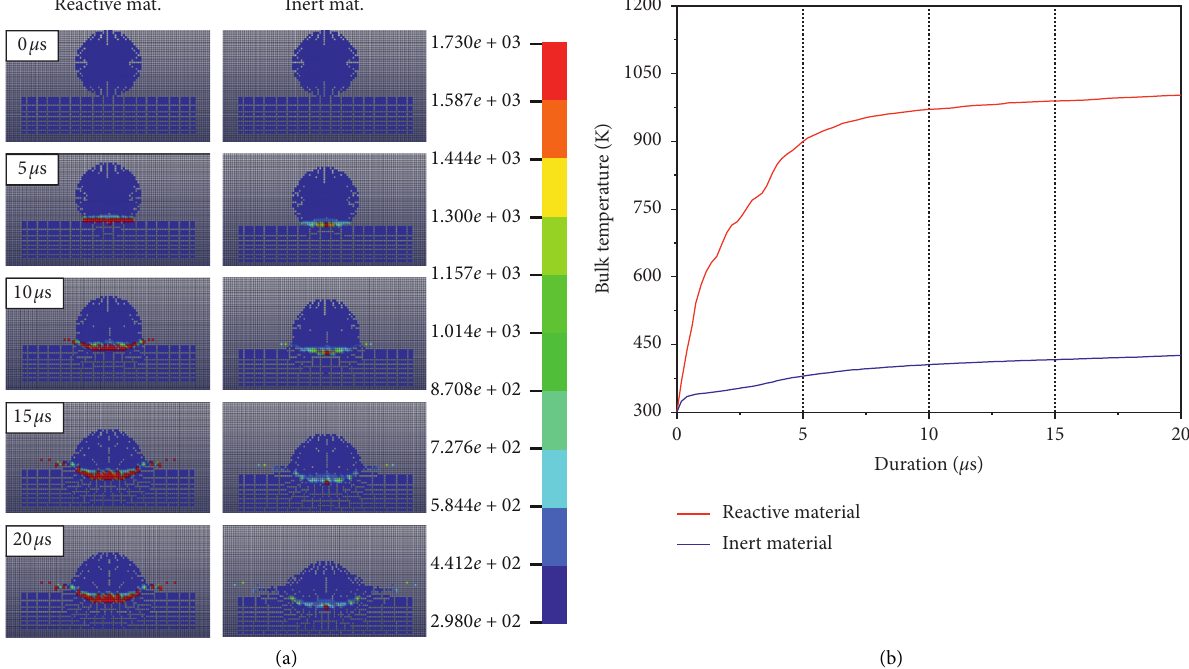
Figure 9: Comparison of temperature between the reactive fragment and inert fragment. (a) Time-dependent temperature contour of reactive fragment (left) and inert fragment (right) during the penetration. (b) Comparison of bulk temperature between the reactive fragment and inert